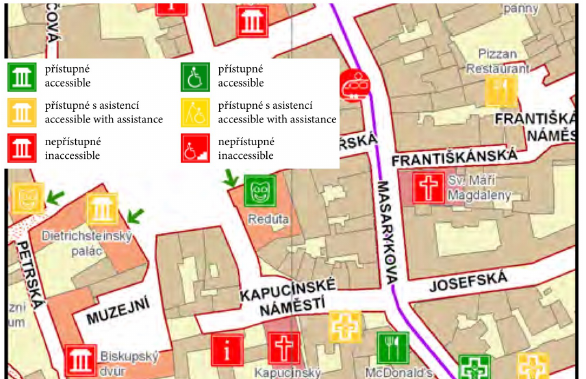
Figure 2. A map of accessibility of a region in the city of